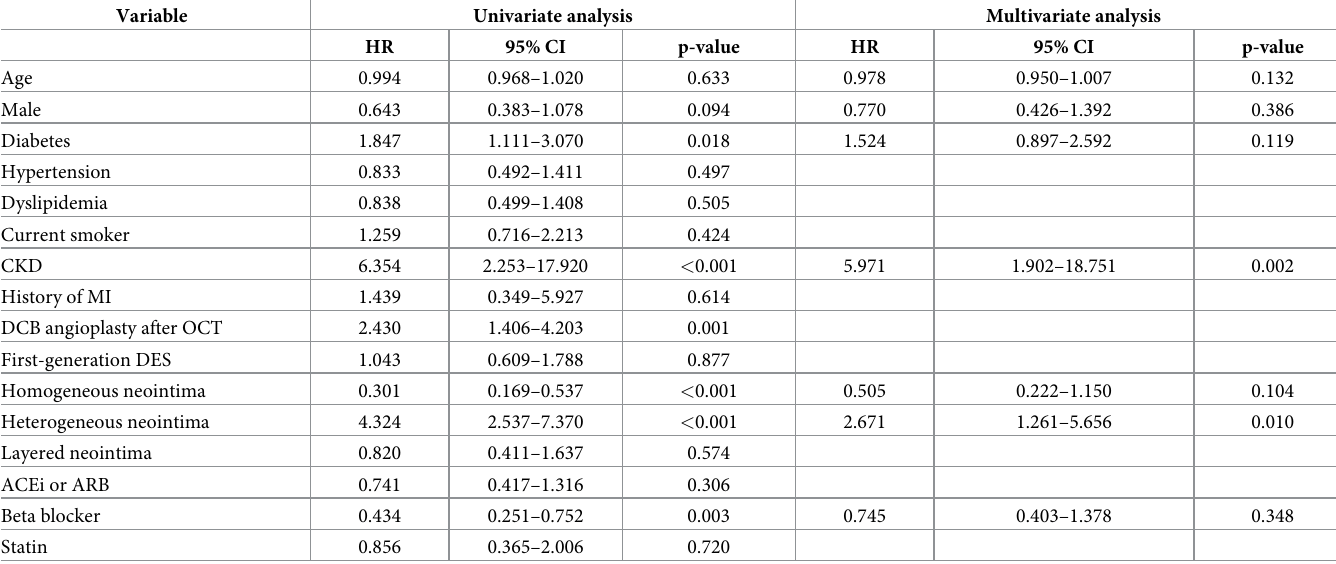
Table 4. Independent predictors for any